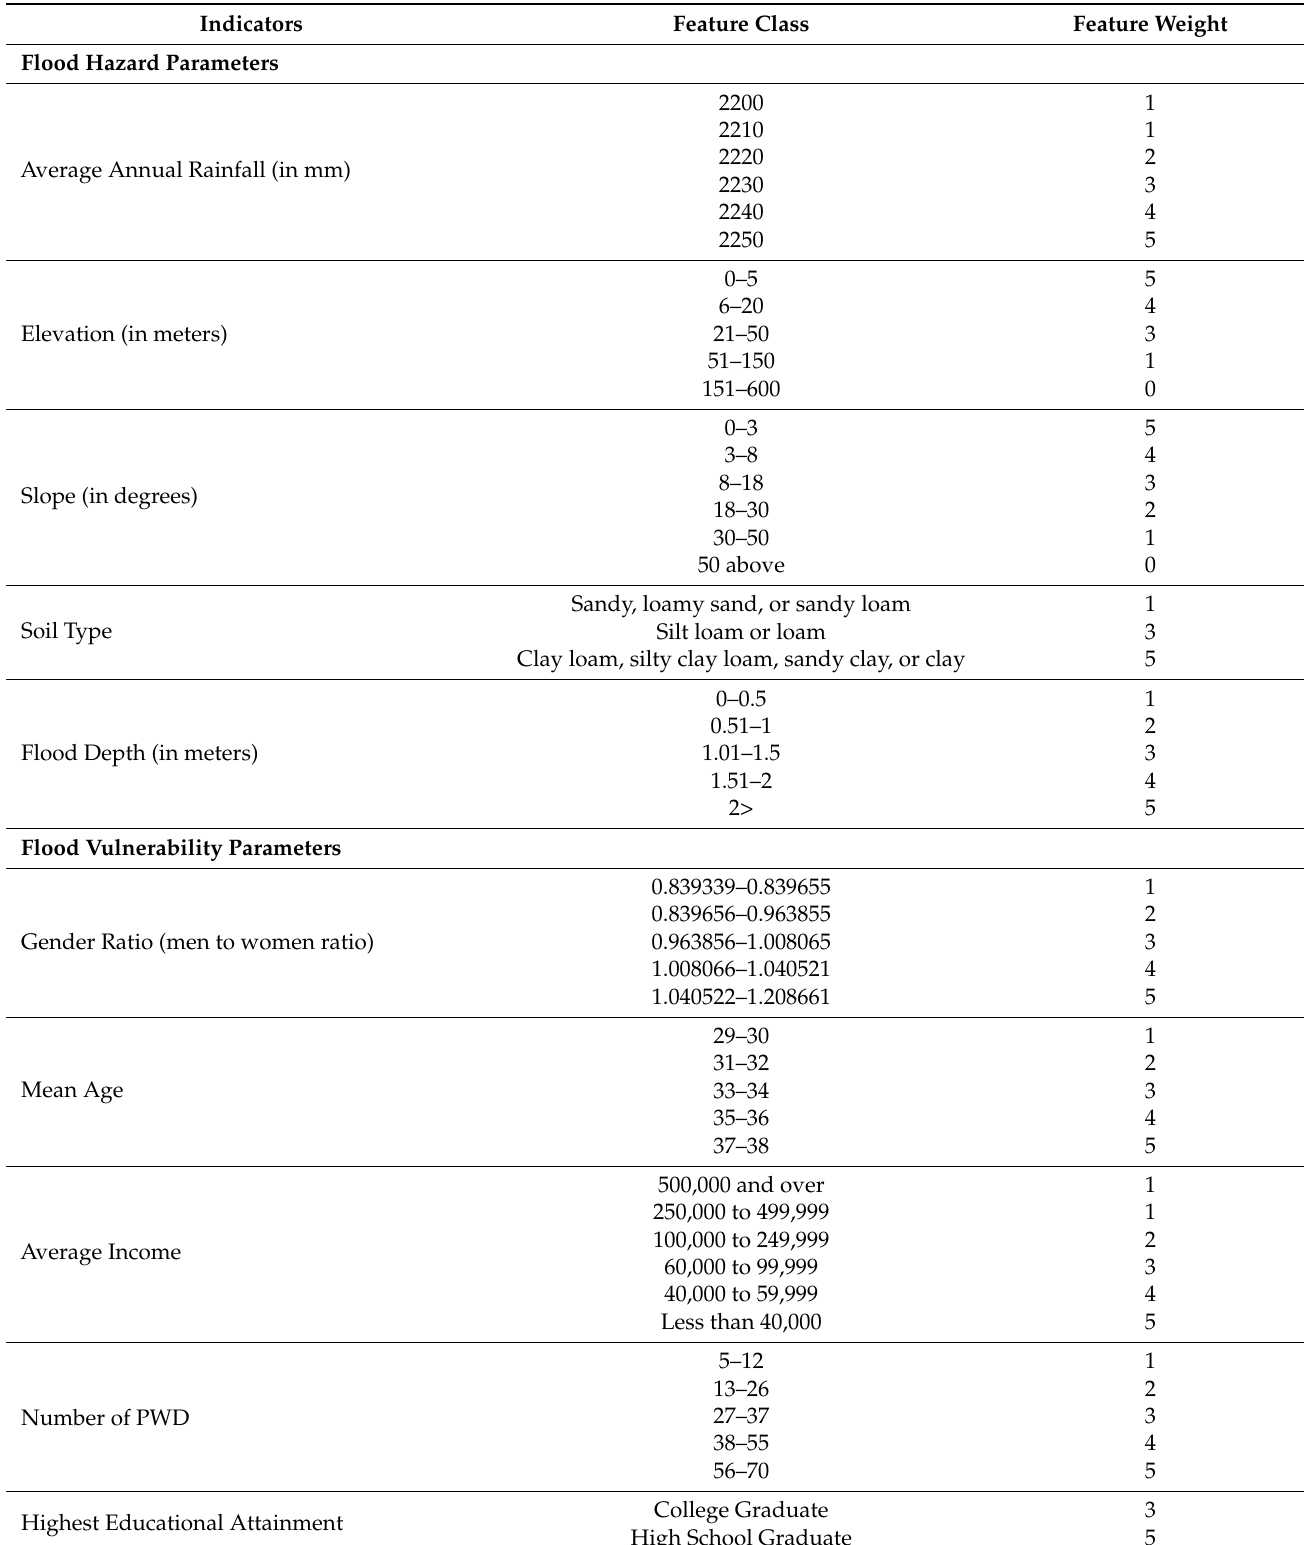
Table A2. Parameters with their designated feature